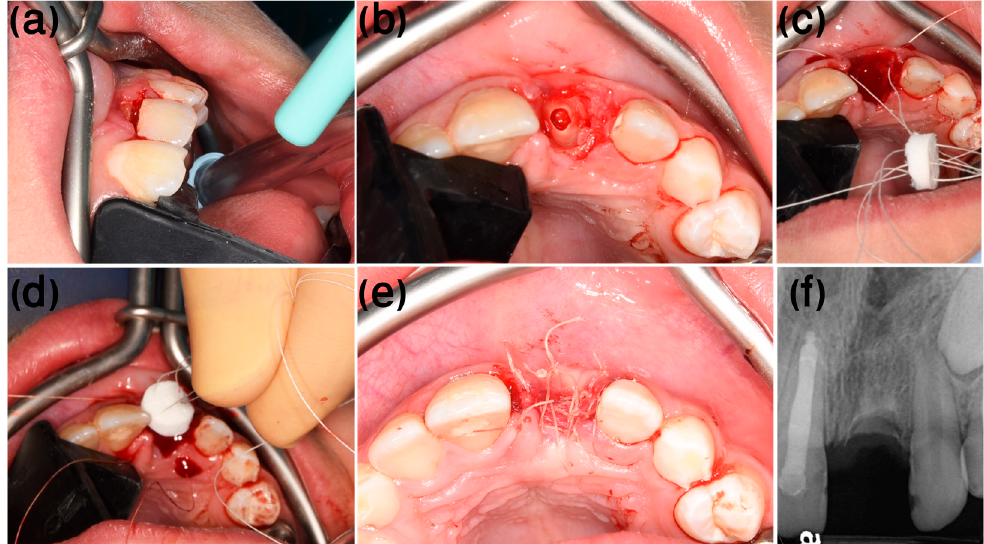
Figure 5. Case 1, flapless decoration procedure. ( a ) The crown of the tooth was separated from the root, 2 mm below the cementoenamel junction, using a diamond bur. ( b ) Occlusal appearance of the root after crown removal. ( c ) A round PDCM was adapted with 5/0 coated VICRYL ® (polyglactin 910) sutures, implementing the “parachute technique”. ( d ) Sutures were tightened simultaneously in all aspects, for ease of manipulation and adaptation. ( e ) Additional simple interrupted bucco-palatal sutures were added as needed for stabilization of the graft. ( f ) Post-op radiograph (The white rotated symbol “a” in the bottom left corner of the figure is part of an embedded symbol in the phosphorus plate by the manufacturer for orientation).